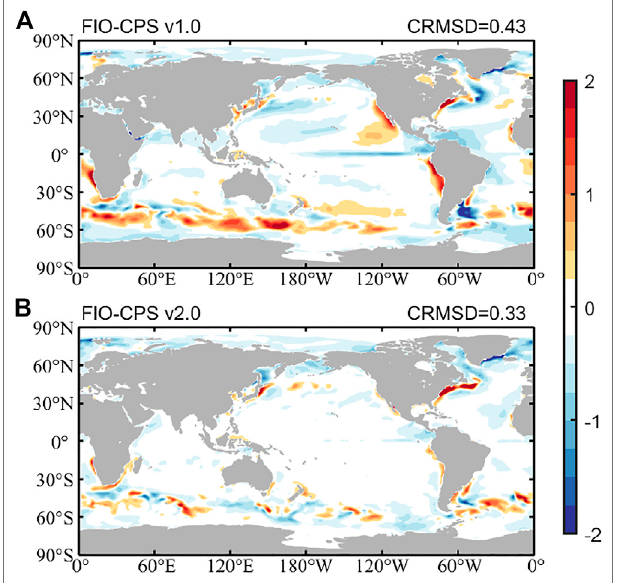
FIGURE 2 | Climatological SST differences (units: ° C) between the initial conditions and COBE SST: (A) FIO-CPS v1.0 and (B) FIO-CPS v2.0. The CRMSD is listed in the top right corners.